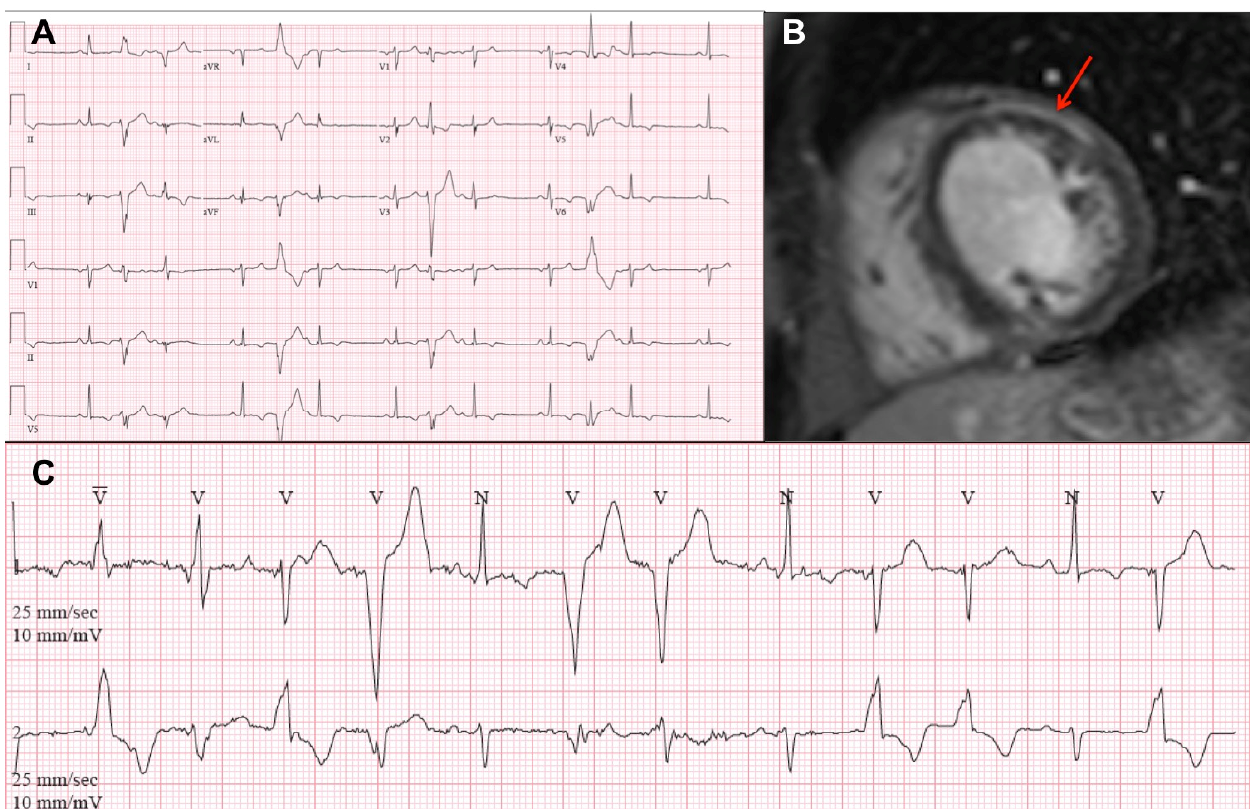
Figure 2. Electrocardiography and cardiac magnetic resonance imaging of two patients with pathogenic truncating variants in the desmoplakin ( DSP ) gene. 12-lead ( A ) and extended outpatient electrocardiographic monitoring ( C ) of Patient ID 13 (c. 888C > G, p. Tyr296*) demonstrated frequent